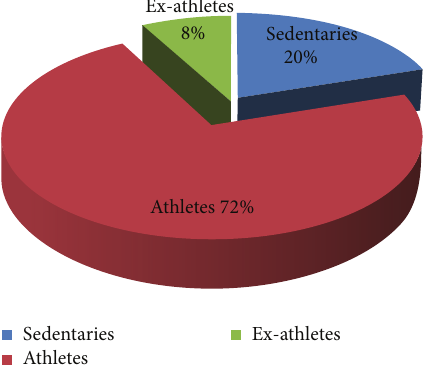
Figure 1: Composition of the whole population investigated (ath- letes, ex-athletes, and sedentaries).